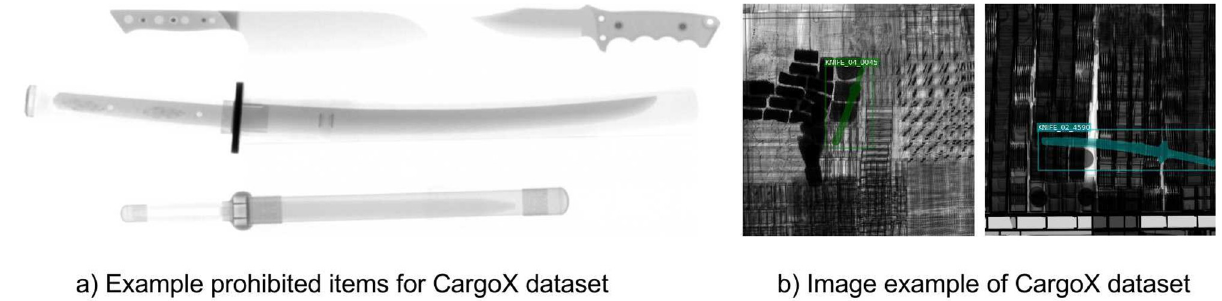
Fig 6. Prohibited items and X-ray security images in the CargoX dataset: a) examples of prohibited items for the CargoX dataset and b) image examples for the CargoX dataset.